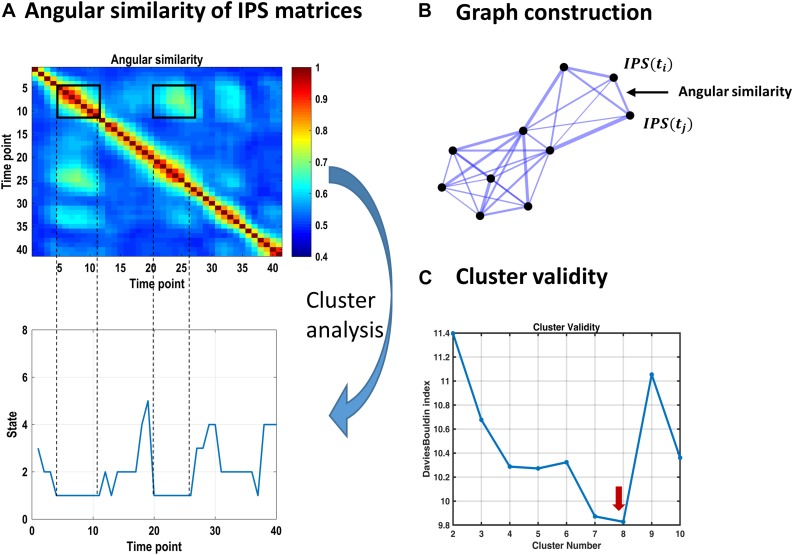
Identifying recurrent IPS patterns through cluster analysis. (A) Top plot shows a representative portion of the (symmetric) angular similarity matrix for 40 consecutive IPS patterns. That is, each entry denotes the angular similarity between two time-indexed IPS matrices (Eq. 5). Recurrent transient patterns are automatically placed in the same cluster, following spectral clustering. For instance, IPS patterns realized between time points 5 and 11 (enclosed by a black square on the diagonal) are highly similar to each other and to the patterns emerging over time samples 20–26. Hence, IPS matrices from both periods identify with the same cluster number (i.e., state 1), as illustrated in the lower panel. (B) Schematic of an (undirected weighted) graph associated with an angular similarity matrix. Each node corresponds to a time-indexed IPS matrix, and edge thickness reflects angular similarity. Using spectral clustering, this graph can be optimally divided into well-connected groups of nodes that are plausibly separated from each other, comprising the clusters of interest. (C) Cluster validity is established using the Davies–Bouldin index (which is the ratio of within-cluster scatter to between-cluster distance) quantified for a range of 2–10 clusters. The lowest value of this index reflects the most plausible clustering solution, which is eight for our data. The associated cluster centroids are illustrated in Figure 4.